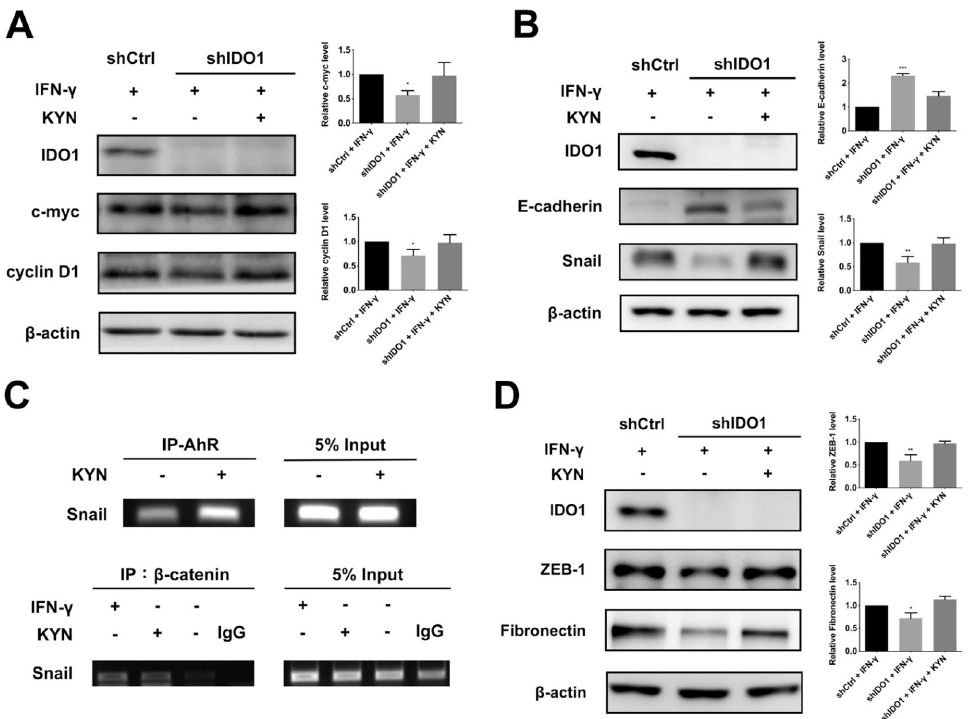
Figure 5. IDO1 enhances HCC proliferation and metastasis through modulation of downstream proliferative and EMT-related markers. ( A ) Expression levels of proliferative markers, c-myc and cyclin D1, under IDO1 and AhR activation. C-myc, cyclinD1 were both upregulated in shCtrl cells by IFN- γ induction relative to shIDO1 cells. Left, control and shIDO1 HuH-7 cells were treated with IFN- γ (40 ng/mL) with or without KYN (100 μ M) rescue, and expression of the indicated proteins analyzed via immunoblotting with specific antibodies. Right, relative quantification of immunoblotting results from three independent replicates. ( B ) Evaluation of expression of the EMT regulator, Snail, and epithelial marker, E- cadherin, under IDO1 and AhR activation. Induction of IDO1 increased Snail and decreased E-cadherin expression in shCtrl cells compared to IDO1 knockdown cells. Left, control and shIDO1 HuH-7 cells were treated with IFN- γ (40 ng/mL) with or without KYN (100 μ M) rescue. Samples were separated via SDS-PAGE and analyzed via immunoblotting. Right, quantitative analysis of variations in Snail and E-cadherin levels. ( C ) The binding of AhR and β -catenin to the promoter of Snail was significantly increased by IFN- γ or KYN induction in HuH-7 cells. Upper, control HuH-7 cells were examined for AhR binding at the Snail promoter region via ChIP assay following induction with or without KYN (100 μ M) for 8 h. Cell lysates were immunoprecipitated with anti-AhR antibody. Specific primers for Snail promoter were used to analyze purified precipitates or input DNA for Snail-specific signals. Lower, analysis of β -catenin binding to Snail promoter region under IDO1 and AhR activation in control HuH-7 cells. Cell lysates were immunoprecipitated with anti- β -catenin anti- body. Specific primers for Snail promoter were used for Snail-specific signal. ( D ) ZEB-1 and fibronectin were significantly upregulated under IDO1 activation in shCtrl cells compared to shIDO1 counterparts. Immunoblot analysis of expression levels of two Snail-regulated mesenchymal markers, ZEB-1 and fibronectin, under IDO1 and AhR induction, left. Right, quantification of alterations in expression levels of ZEB-1 and fibronectin. All statistical data were calculated from three independent replicates (shCtrl, control shRNA; shIDO1, shRNA against IDO1; *, p < 0.05; **, p < 0.01; ***, p < 0.001).